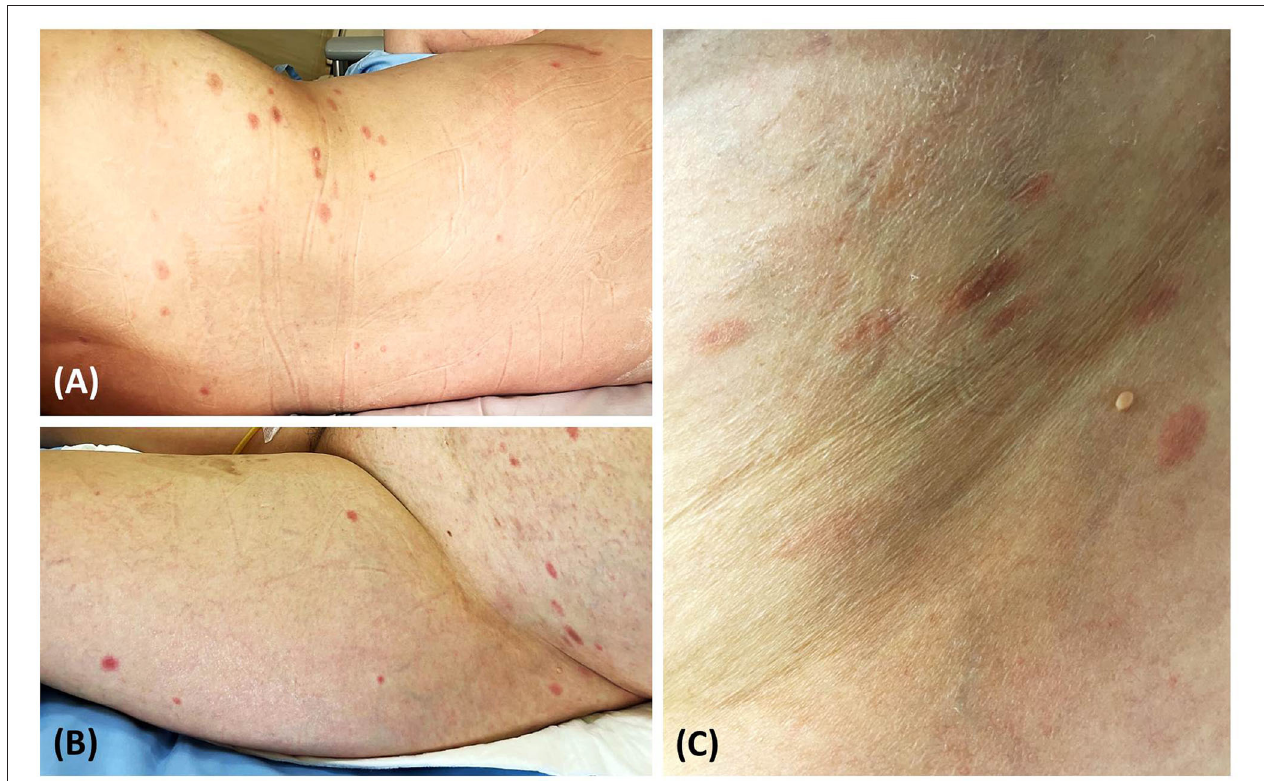
FIGURE 1 | Pityriasis rosea-like eruption presenting as multiple discrete erythematous oval patches and plaques on the back (A) lower abdomen, and bilateral upper thighs (B) ; lesions distributed along cleavage lines without prominent scales (C) .